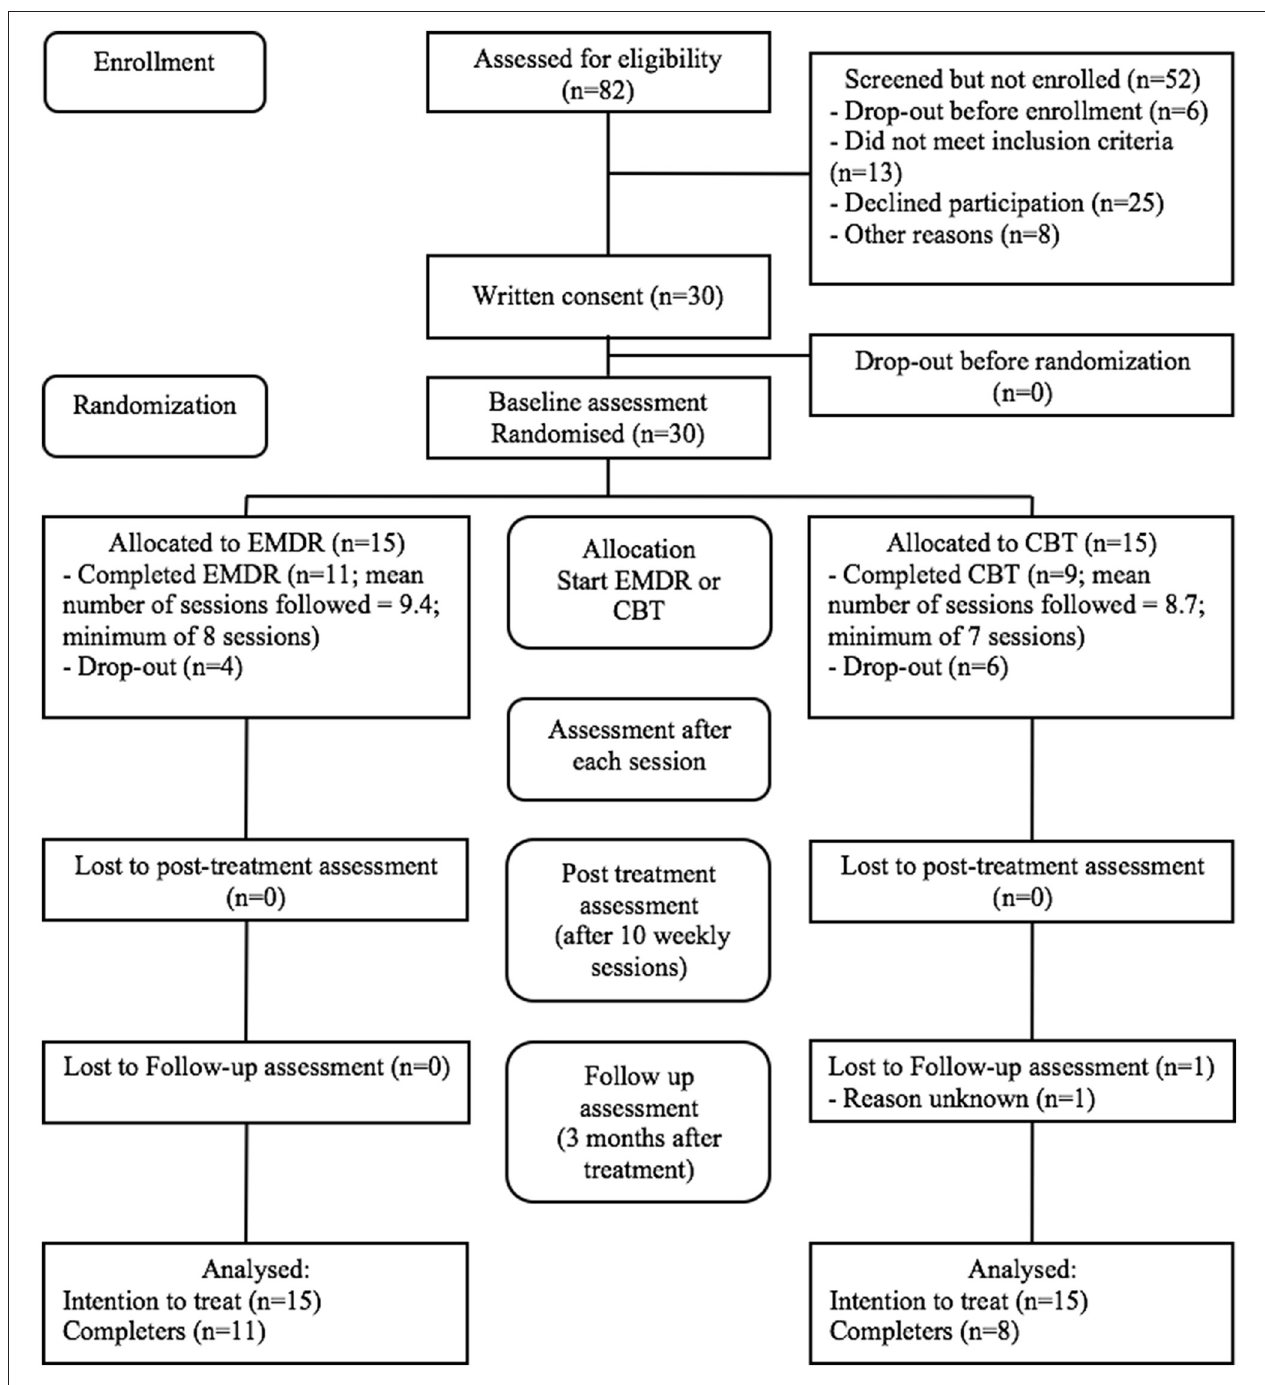
FIGURE 1 | Flow chart of the